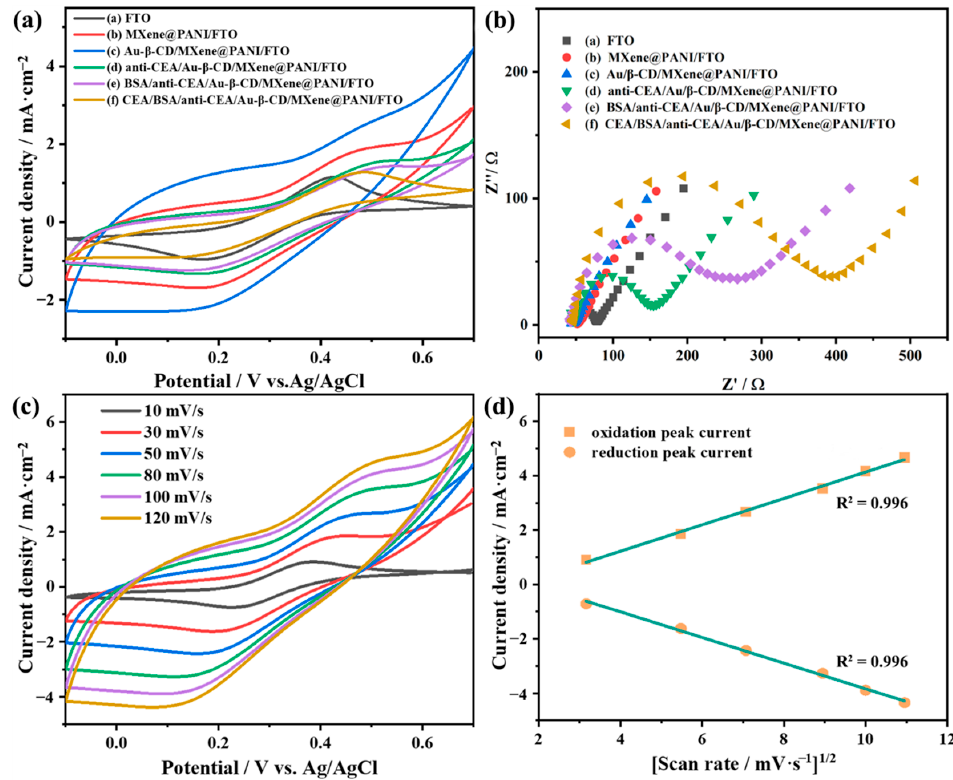
Figure 3. ( a ) Cyclic voltammogram and ( b ) EIS spectra of electrodes at different fabrication steps. ( c ) Cyclic voltammogram and ( d ) Randles–Šev č ík plot of Au- β -CD/MXene@PANI/FTO at different scan rates from 10 to 120 mVs − 1 .